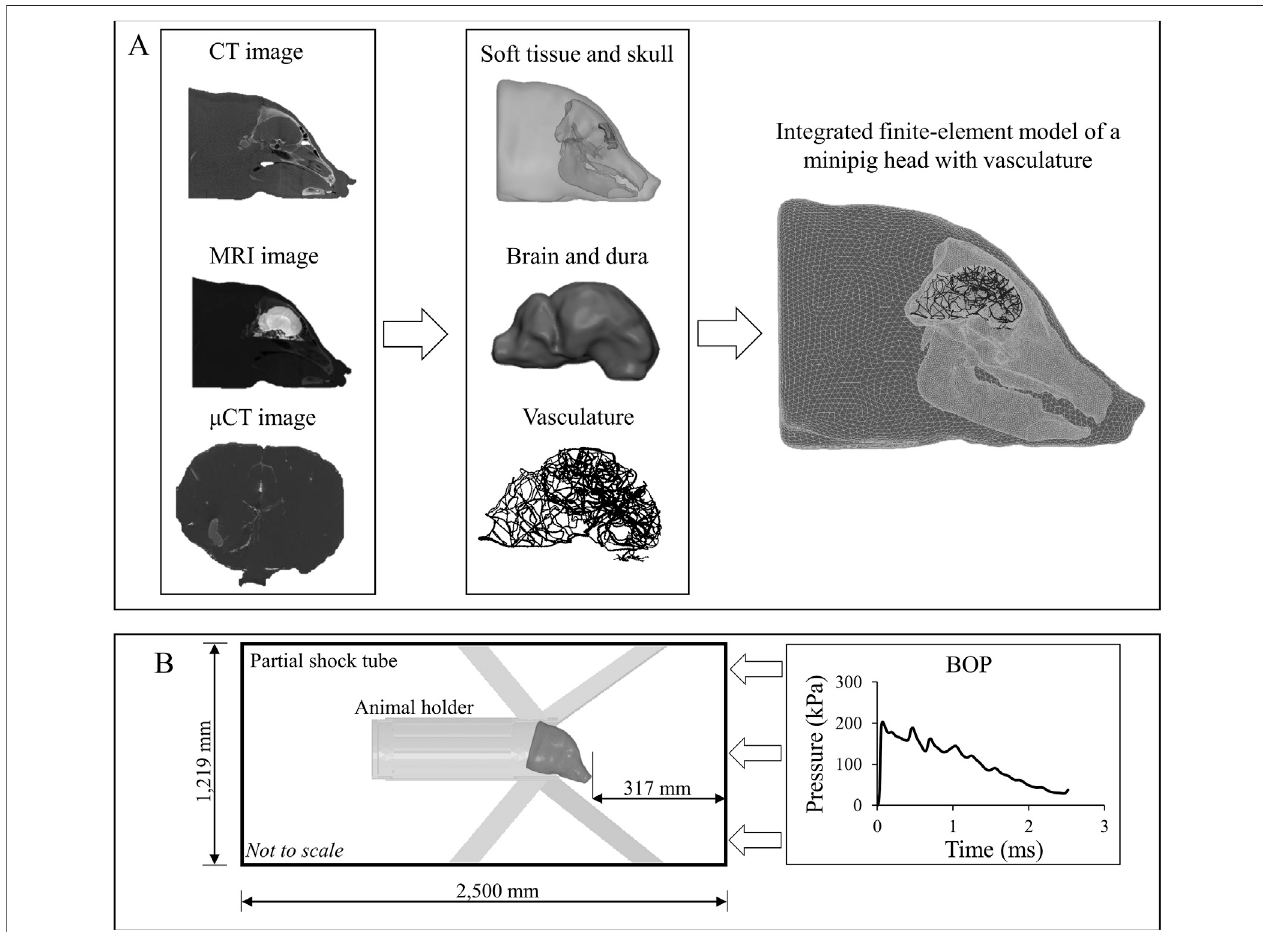
FIGURE 2 | Development of a high- fi delity three-dimensional (3-D) fi nite-element (FE) model of a Göttingen minipig and the computer simulation setup. (A) To develop the high- fi delity 3-D FE model of a Göttingen minipig, fi rst, we used computed tomography (CT) scans of the skull and surrounding soft tissue, magnetic resonance imaging (MRI) scans to capture the geometry of the brain and dura, and micro-computed tomography ( μ CT) scans to acquire the details of the vasculature. Next, using these scans, we developed two-dimensional surface models and converted them into 3-D FE models. Then, we integrated the FE models of the soft tissue, skull, dura, brain, and vasculature to create a FE model of a minipig head. (B) To perform the blast simulations, we combined the integrated minipig-head FE model with theFE model oftheanimalholder and coupled them witha3-D partialshock-tube FE model. Using the experimentally measured incident blastoverpressure (BOP) as input to the shock-tube model, we performed computer simulations with the minipig head in the prone position facing the BOP.